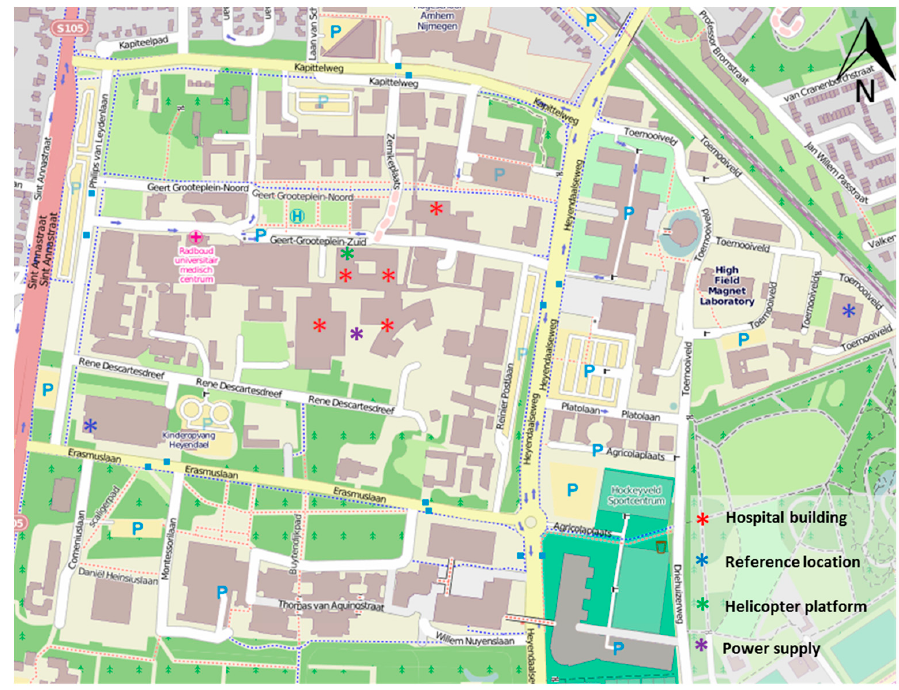
Figure 1. Hospital buildings and reference locations where indoor measurements were conducted, and helicopter platform and diesel-fueled power